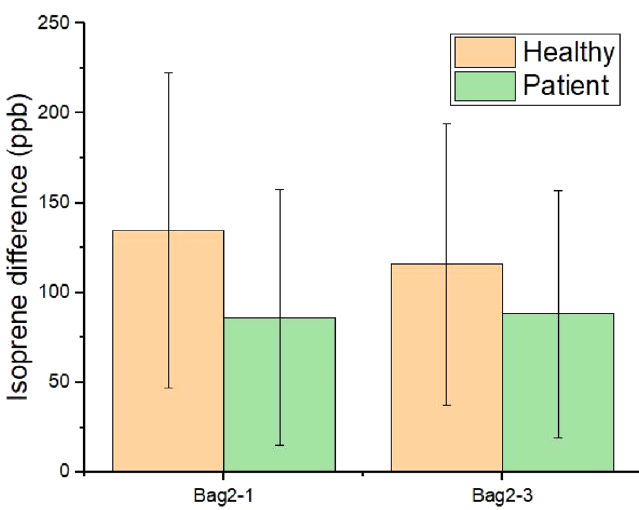
Figure 4. Isoprene concentration (ppb) difference from collected exhaled breath of patient and healthy group (Bag2-1: before physical activity and after physical activity, bag2-3: after physical activity and after 15 min of rest).